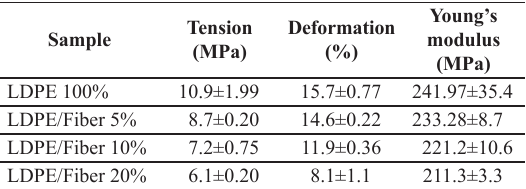
Figure 5. Composites of low-density polyethylene composites containing treated babassu fiber. Table 1. Results of the tensile test for the composites of LDPE with babassu